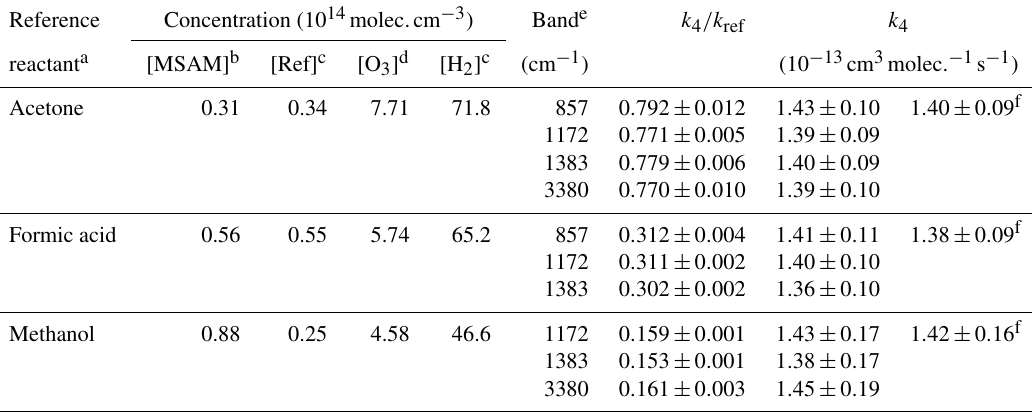
Table 2. Rate coefficient ratios and experimental conditions for the relative rate experiments. Reference Concentration (10 14 molec . cm − 3 )